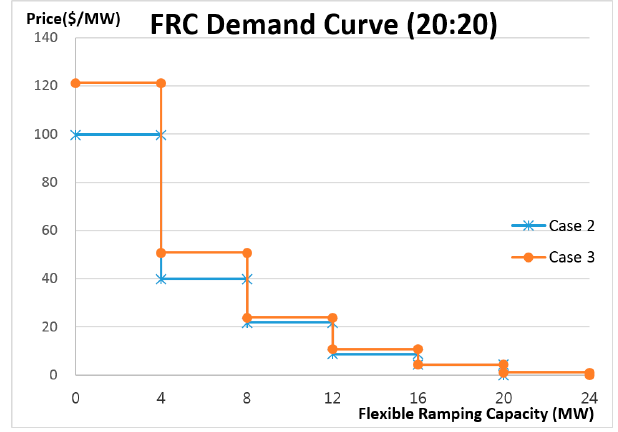
Figure 9. The FRC demand curve at t = 20:20.